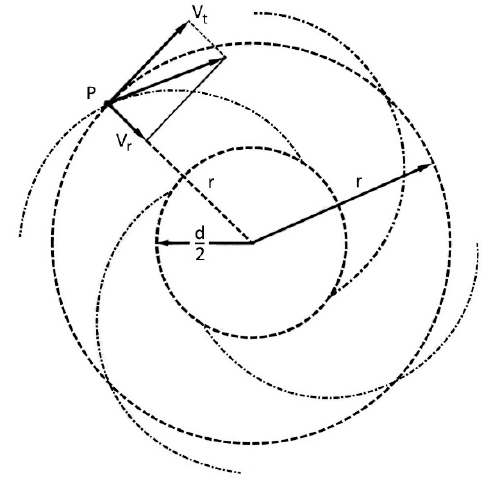
Figure 6. Flow around the exhaust of a cyclone [16].